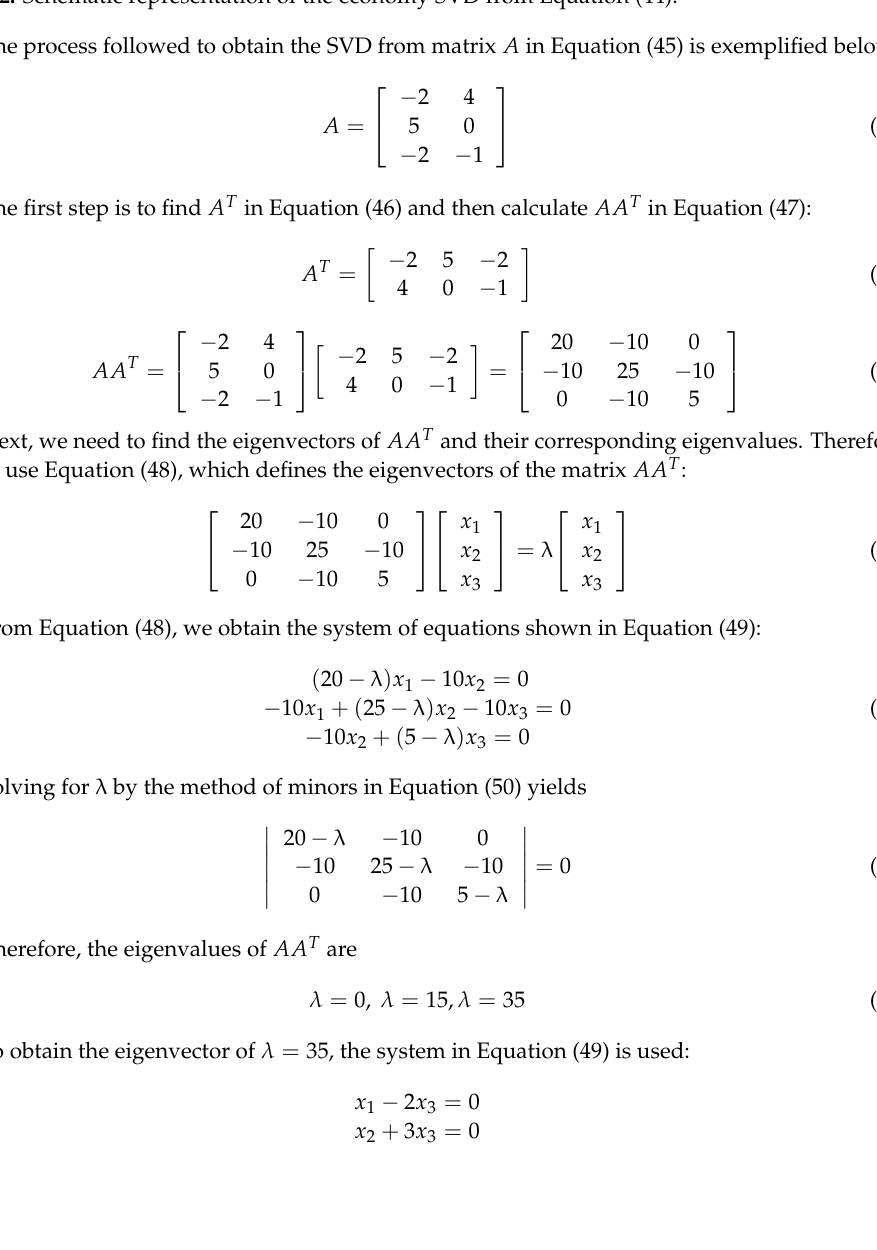
Figure 2. Schematic representation of the economy SVD from Equation (44).